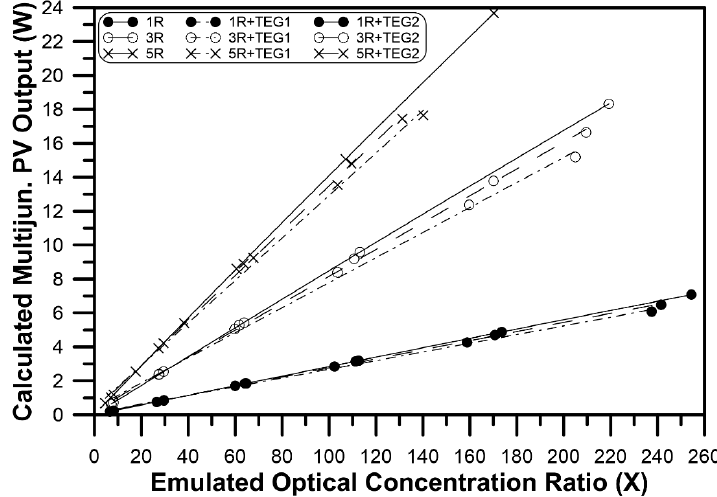
Figure 8. Electrical output of the Ga 0.35 In 0.65 P/Ga 0.83 In 0.17 As multijunction PV cell.